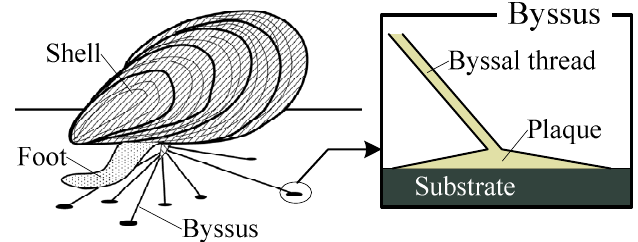
Fig. 1 Schematic view of the mussel.